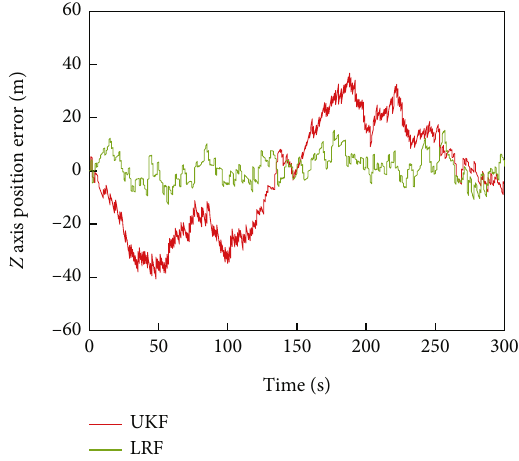
Figure 11: Z -axis position error contrast